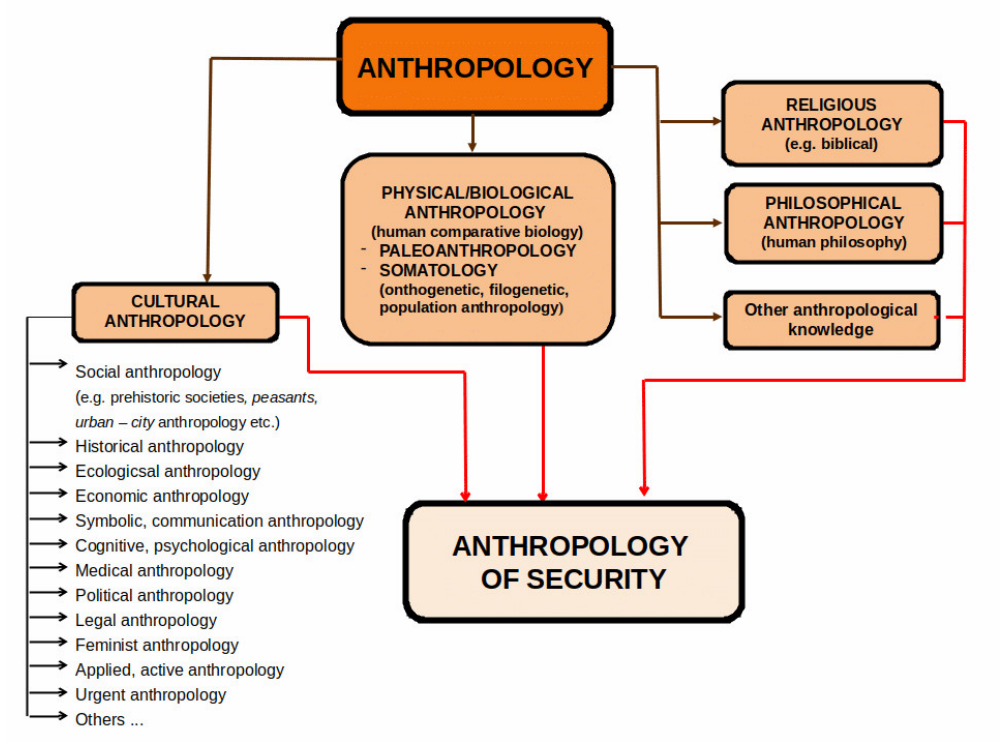
Figure 1. Anthropology of security among anthropological